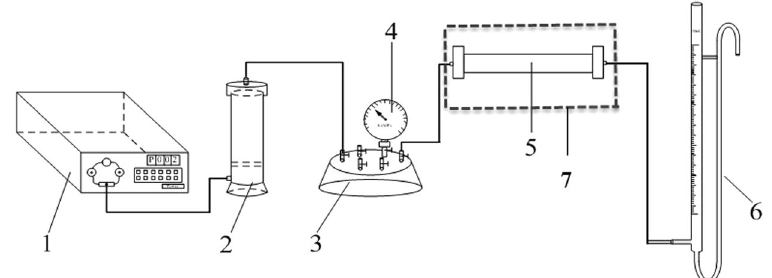
Figure 1. Oil displacement experimental apparatus. 1 Constant-flux pump. 2 Accumulator; 3 Six-way valve. 4 Pressure gauge; 5 Core holder. 6 Oil-water separation pipe. 7 Constant-temperature oven.